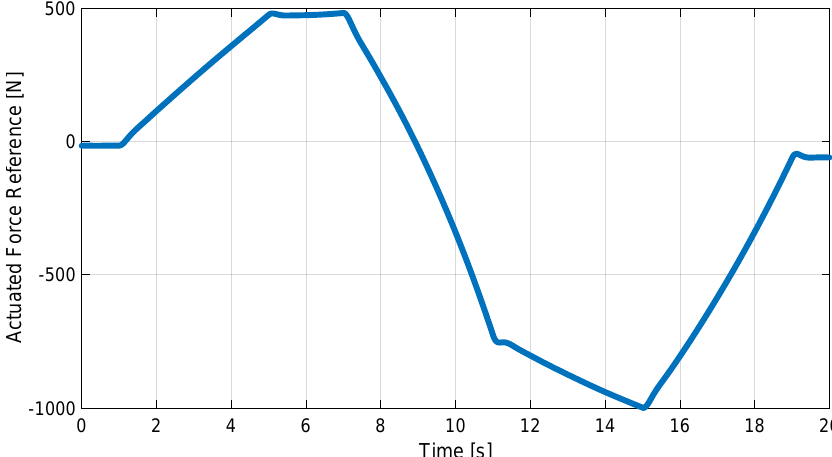
Figure 19. Simulation #3: Actuated Force Reference.